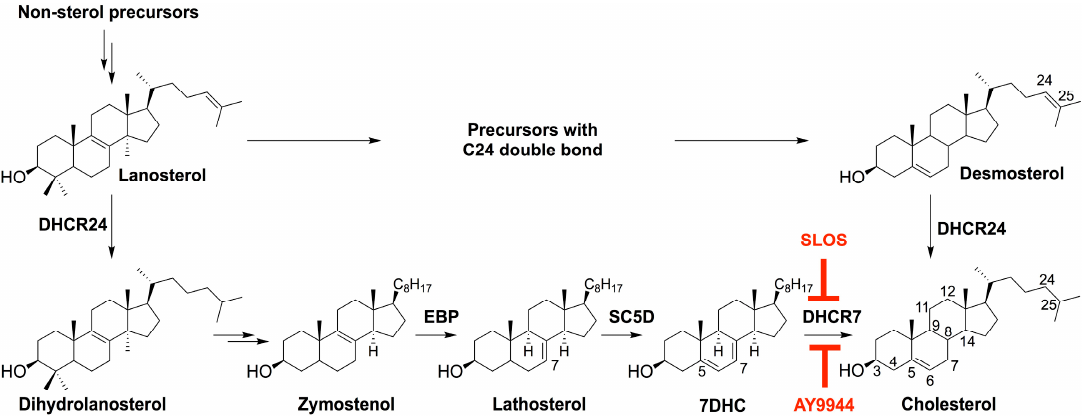
Figure 1. Post-squalene cholesterol biosynthetic pathway. Site of enzymatic inhibition by AY9944 is indicated as well as the locus of the defect in Smith-Lemli-Opitz syndrome (SLOS) at the level of DHCR7. Structures of cholesterol (Chol), 7-dehydrocholesterol (7DHC), and numbering for nomenclature are shown. EBP, 3 β -hydroxysterol- Δ 8 , Δ 7 -isomerase; DHCR24, 3 β -hydroxysterol- Δ 24 -reductase; SC5D, sterol-C5-desaturase; DHCR7, 3 β -hydroxysterol- Δ 7 -reductase.